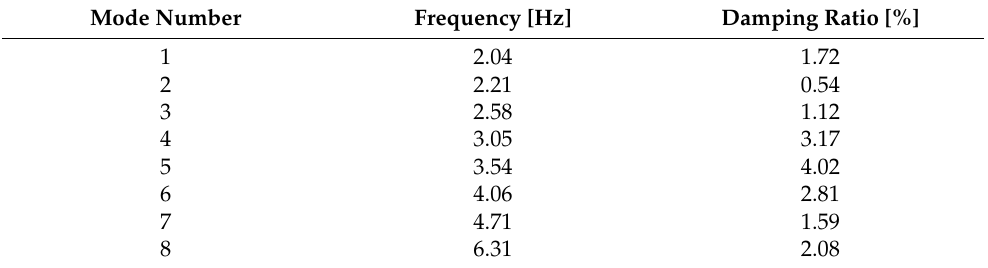
Table 1. Natural frequencies and damping ratios for the B1 bridge.